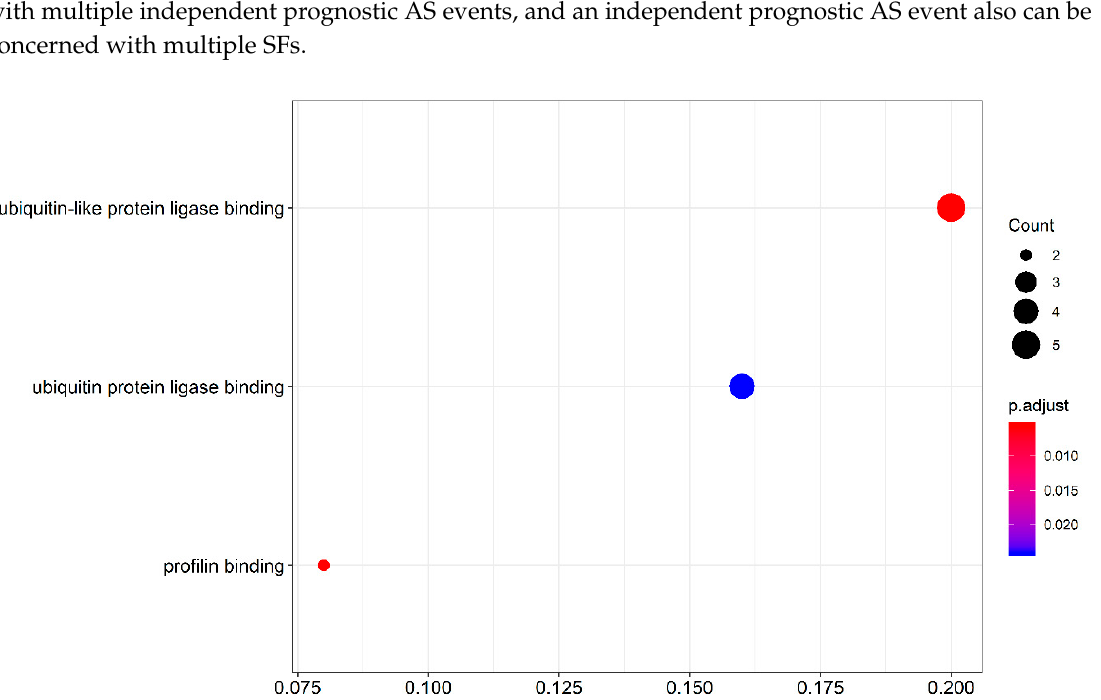
Figure 8. Survival-associated potential SF–AS regulatory network in breast cancer. Triangles ( n = 18) represent SFs, red circles represent AS events associated with poor prognosis, green circles represent